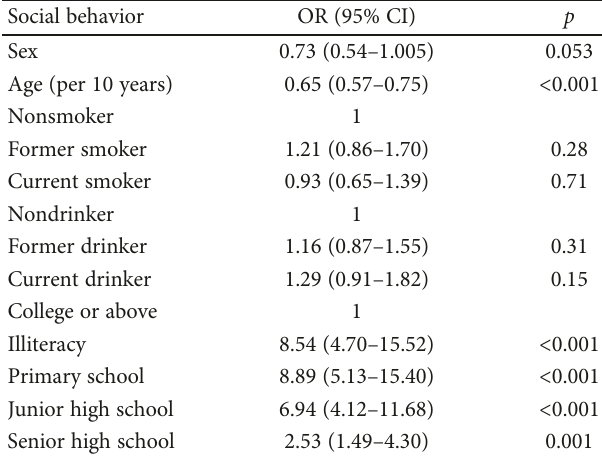
Table 3: Prevalence of physical activity